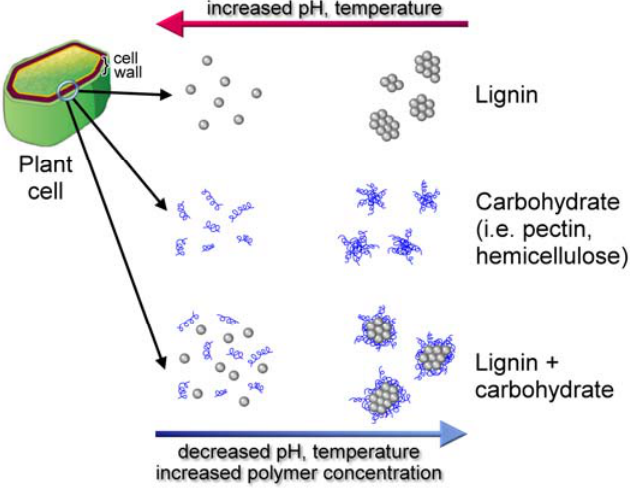
Figure 9. Schematic of supramolecular self-assembly of lignin and lignin-carbohydrates